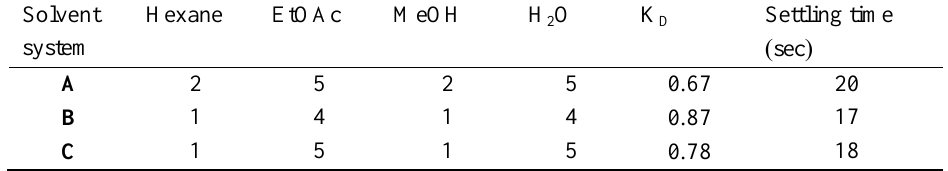
Table 1: Two phase solvent systems, solvent composition, partition coefficient (K D ) and Settling time of TF